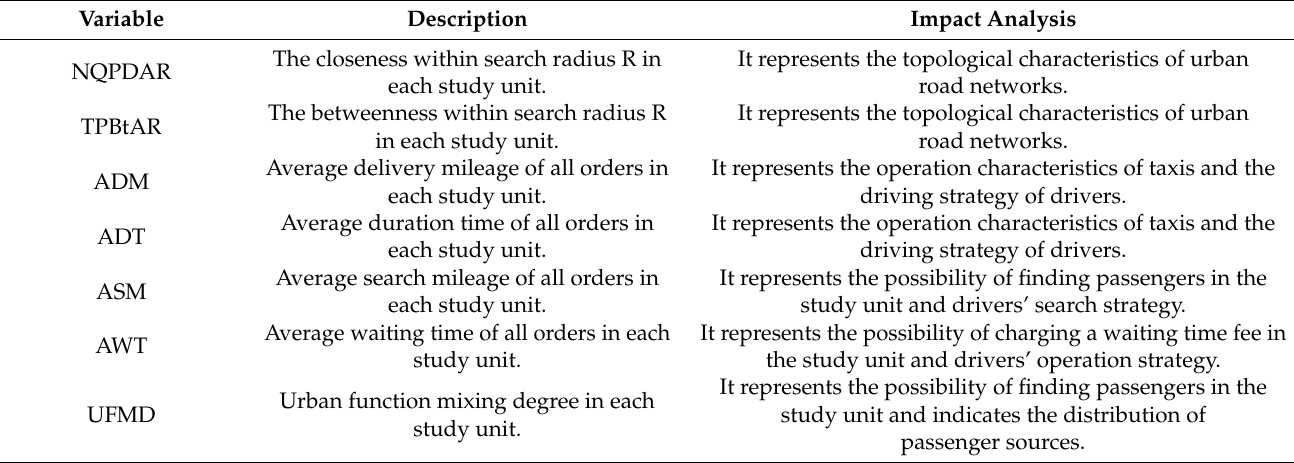
Table 1. Description of explanatory